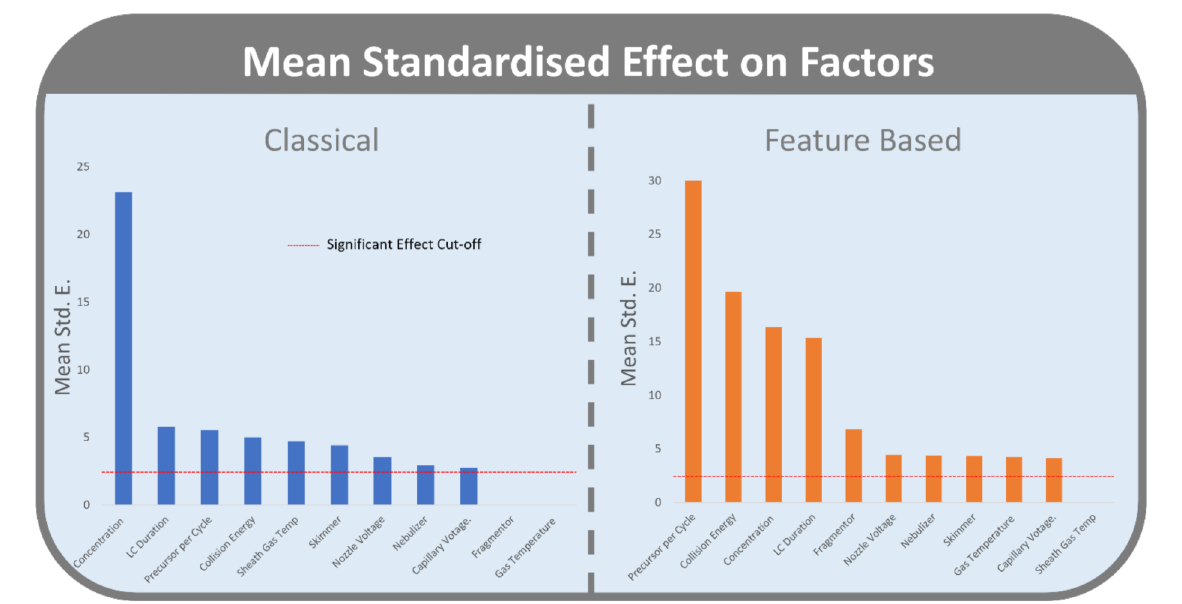
Figure 2. Nomenclature used for molecular networking ( left ) and DoE response modelling ( right ).